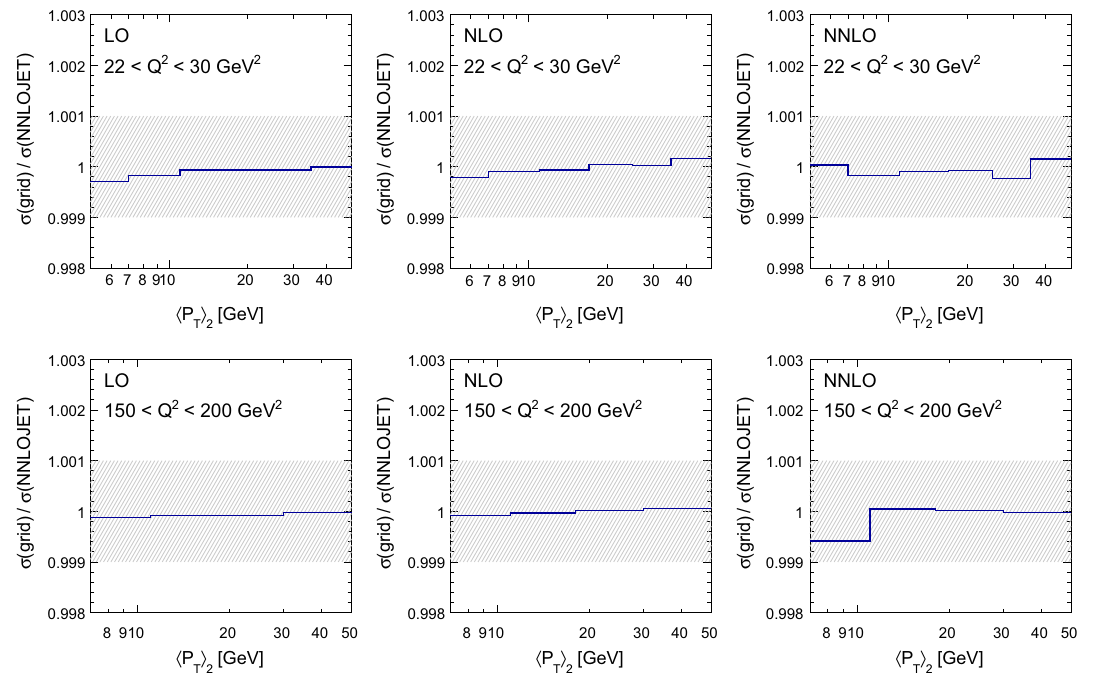
Fig. 2 Validation of the grid accuracy in di-jet production at low- Q 2 (22 < Q 2 < 30GeV 2 , top row) and high- Q 2 (150 < Q 2 < 200GeV 2 , bottom row). The shaded area indicates an agreement of 0.1%